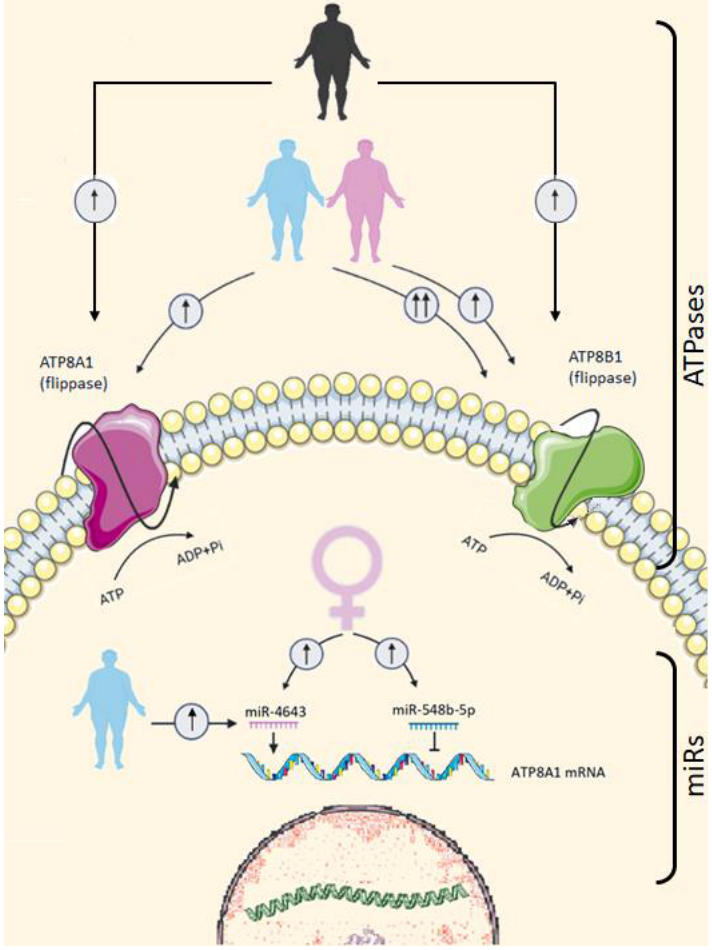
Figure 4. Illustration of the pathways proposed in the present study through which obesity and sex influence ATP8A1, ATP8B1, miR-548b-5p, and miR-4643 gene expressions, and the ATP8B1 modulation by miRs. The black colour of the human figures represents all patients, the pink colour represents obese women, and the blue colour represents obese men. In summary, obesity increased the levels of ATP8A1 and ATP8B1 gene expression, although the effects of obesity were stronger in men than in women, especially for ATP8A1. On the other hand, sex influenced ATP8A1-modulator miRs, miR-548b-5p, and miR-4643 — namely, their levels were increased in women. Moreover, there was an interaction between sex and obesity, according to which obesity increased the levels of miR-4643 in men and, conversely, tended to decrease their levels in women.